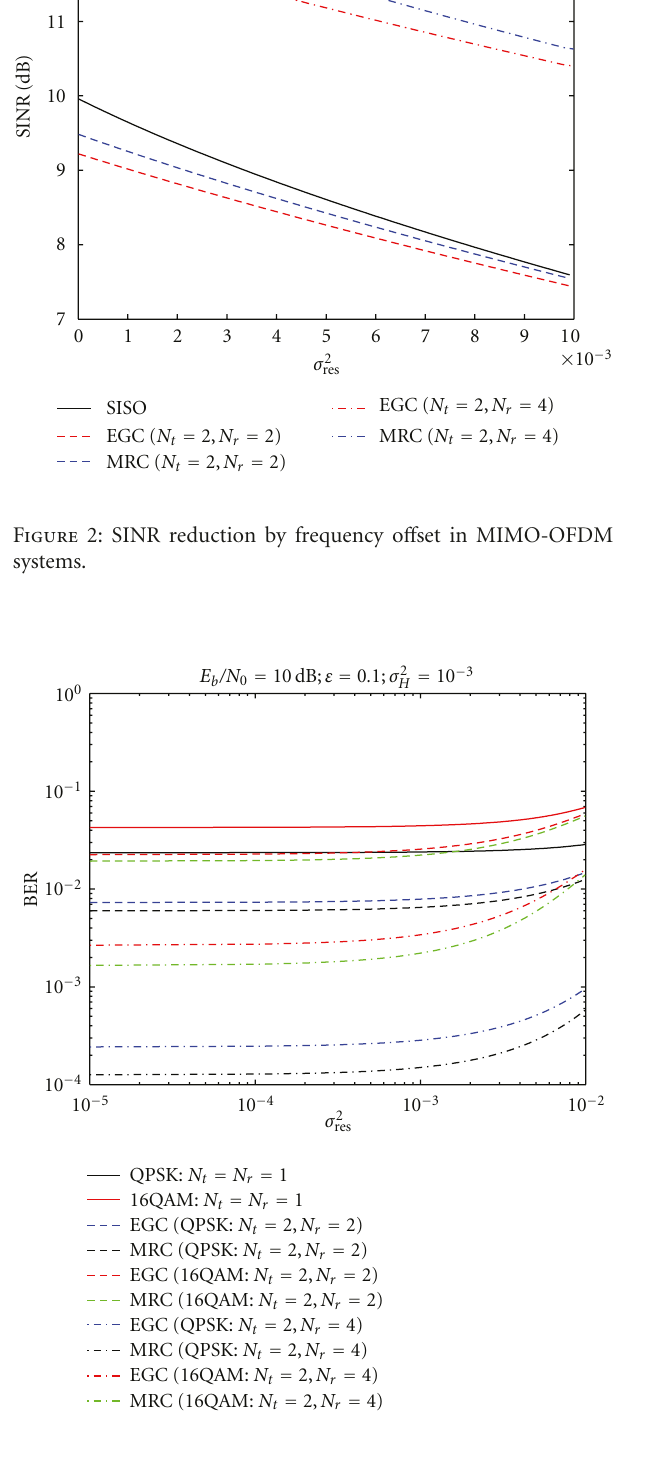
Figure 3: BER degradation due to the residual frequency o ff set in MIMO-OFDM systems.